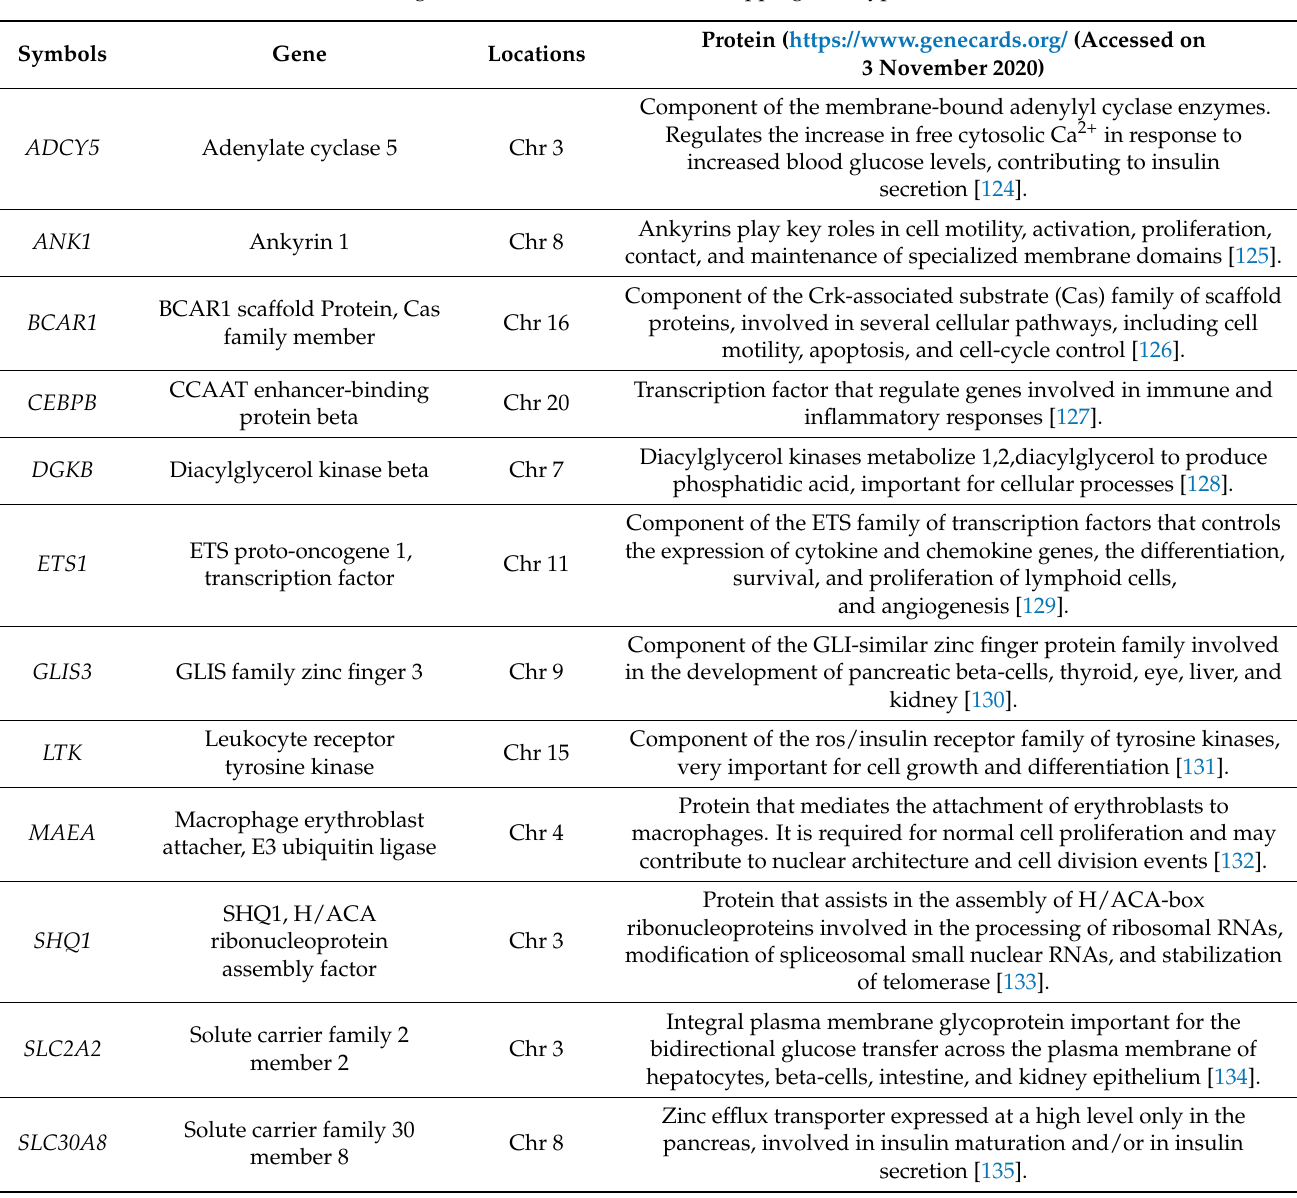
Table 3. List of additional genetic modifiers of CFRD overlapping with type 2 diabetes (T2D) [121]. Protein (https://www.genecards.org/ (Accessed Symbols Gene Locations